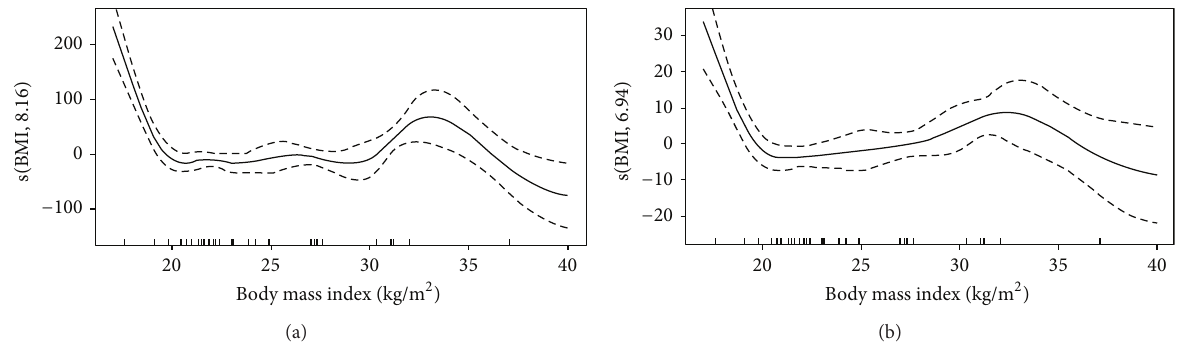
Figure 3: Association between IL4 (a) and IL5 (b) levels and body mass index. Intervals are Bayesian credible intervals.